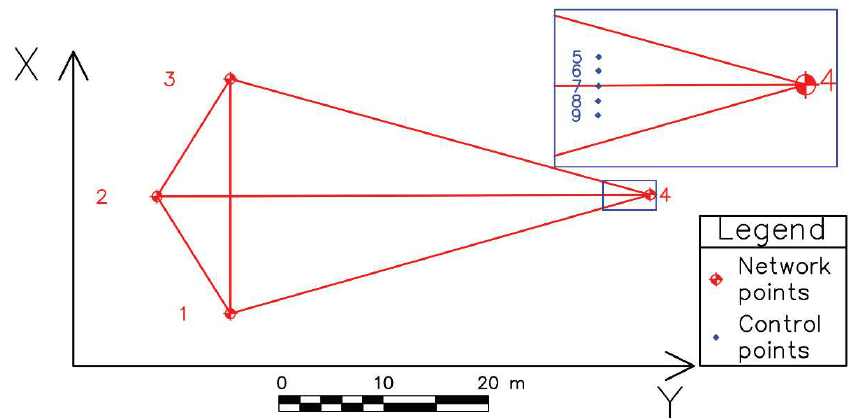
Figure 4. Geodetic micro-network.